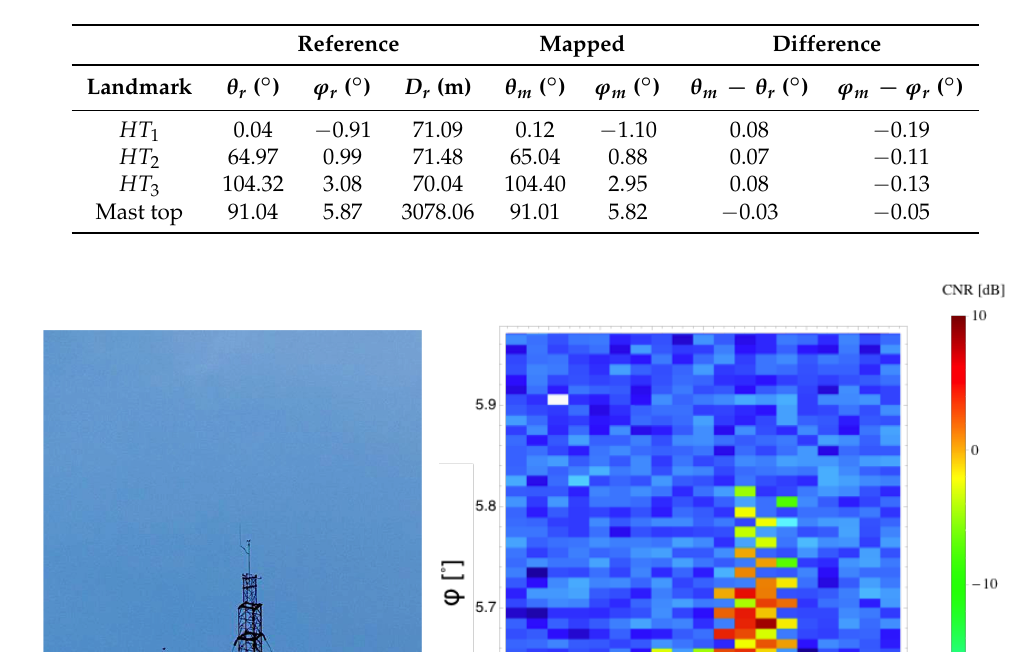
Table 4. Reference and mapped positions of landmarks (azimuth angle, θ ; elevation angle, ϕ ; distance, D ).